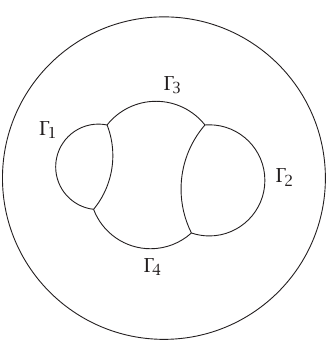
Figure 7.10 . Generating curve for an (unstable) nonstandard double bubble in S n where the single disconnected region has two